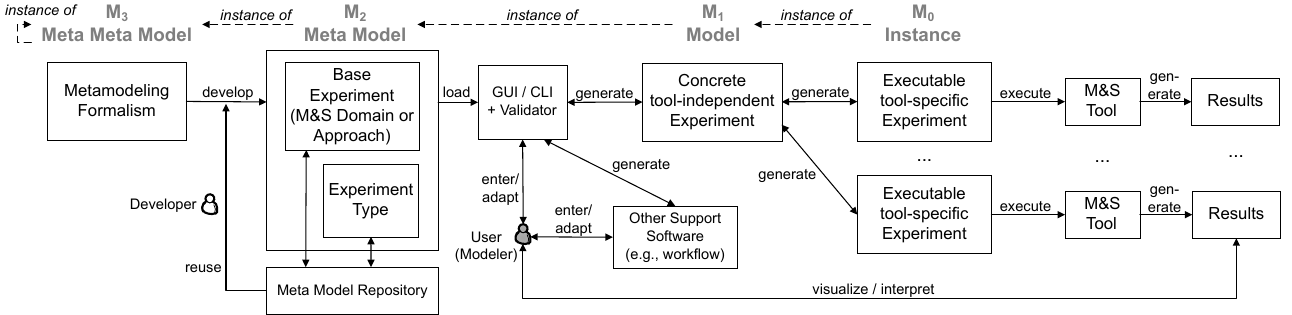
Figure 2. Four-layered MDE architecture [37] for simulation experiments. The level of abstraction decreases from left to right. The experiment meta models (consisting of the base experiment and experiment type; see layer M 2 ), developed based on a meta modeling formalism (layer M 3 ), are at the heart of the approach. Based on M 2 , a tool-independent, exchangeable experiment specification can be generated ( M 1 ), which then forms the basis to derive an executable, tool-specific specification ( M 0 ) based on tool-specific mapping information. The generated experiment specification can then be automatically executed using a backend binding. Additional support components such as meta model repositories, GUIs, and validators assist users in conducting simulation experiments effectively, such that the remaining tasks concerning the user are entering or adapting information via the given interface and visualizing and interpreting the experiment results. The experiment generation pipeline may be used either as a stand-alone application or integrated with other support software, for example a workflow via a